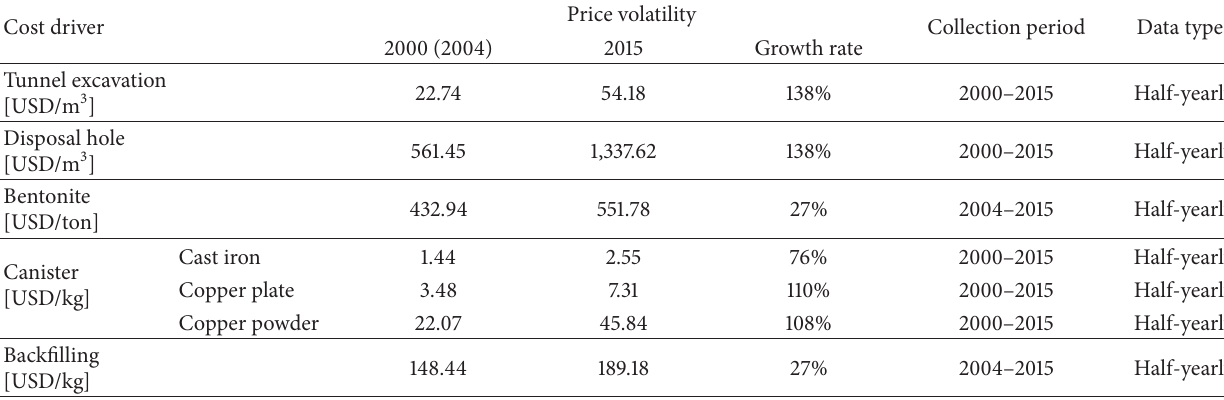
Table 3: Characteristics of the collected data.